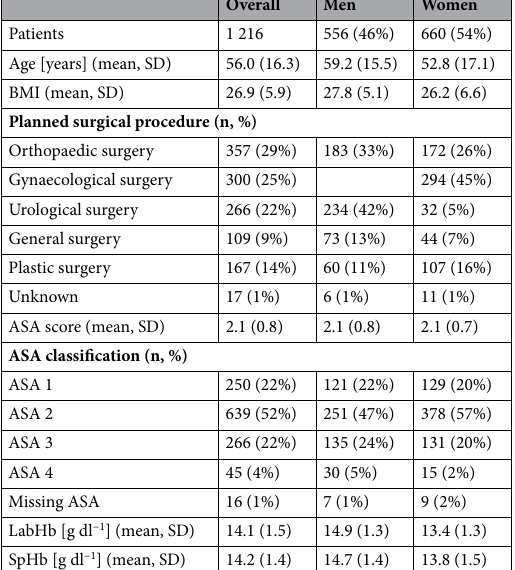
Table 1. Patient characteristics and haemoglobin measurements.